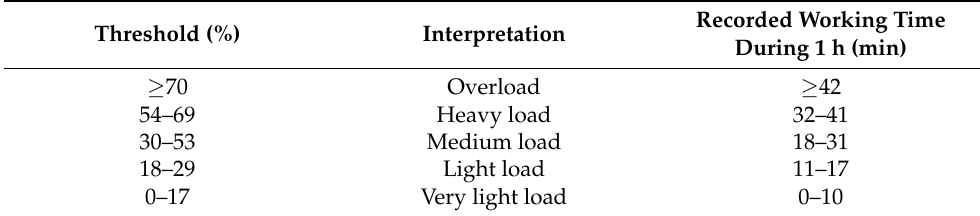
Table 1. Recorded working time during 1